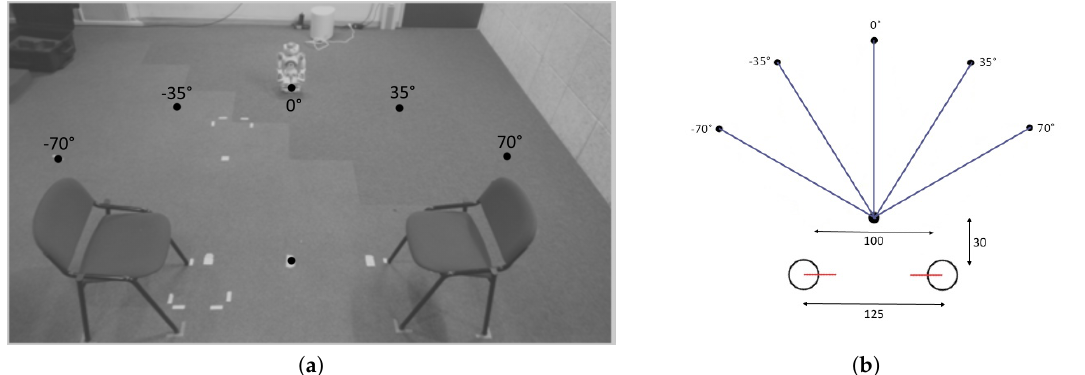
Figure 1. This figure shows ( a ) a picture and ( b ) a schematic overview of the setup in the lab for study 1. The two chairs are placed in a face-to-face (I-shape) formation. The starting points of the robot are indicated with black dots on the circular plane around the chairs. The target location of the robot is indicated with the black dot between the